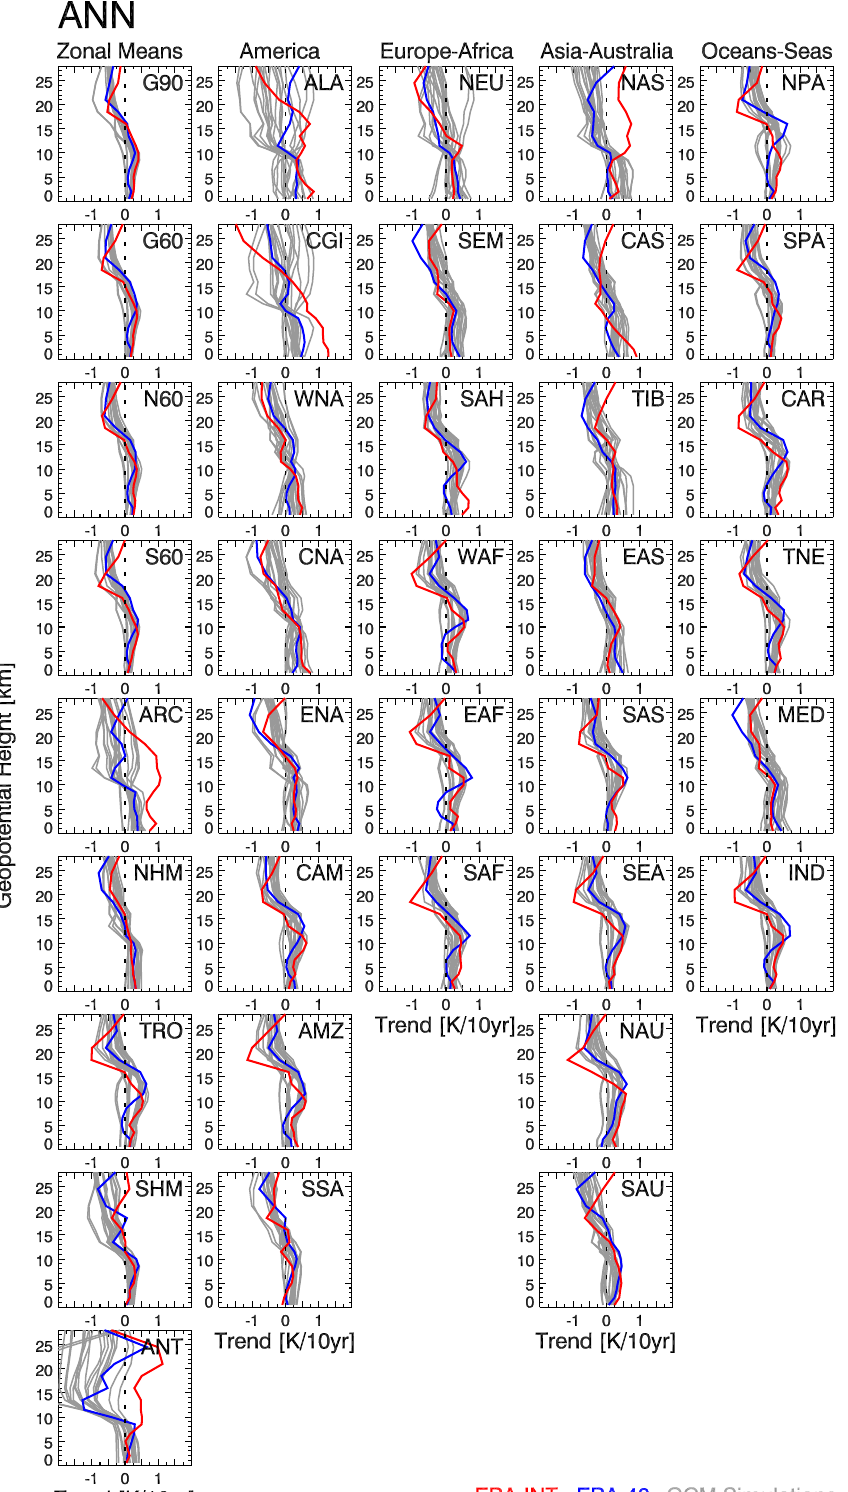
Fig. 5. 10-year temperature trends of annual means for all 37 regions of Fig. 3. ERA-INT trends (1989 to 2005) are shown in red, ERA-40 trends (1980 to 2001) in blue, and GCM trends (1980 to 2001) in grey. Trends for the large-scale zonal mean bands, as commonly provided by single-satellite RO measurements, are depicted in the leftmost column, the other columns show the results for the regions accounting to three continental sections (middle columns) and for oceans and seas (rightmost